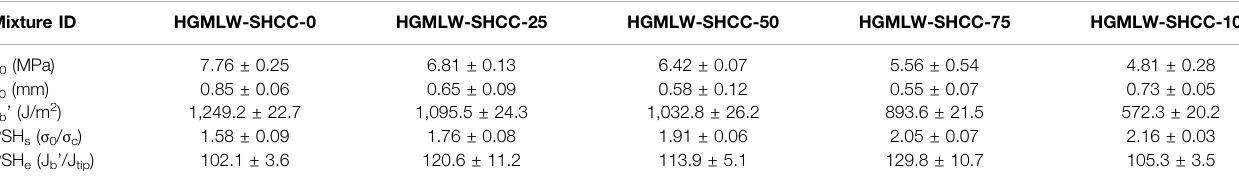
TABLE 5 | Single-crack tensile test results and PSH